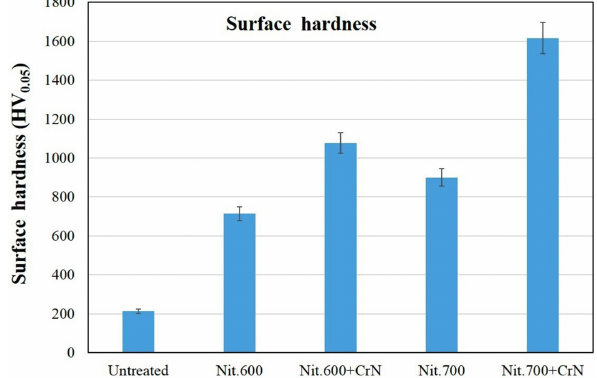
Figure 5: The graph of surface hardness values of the untreated and treated pure titanium specimens.